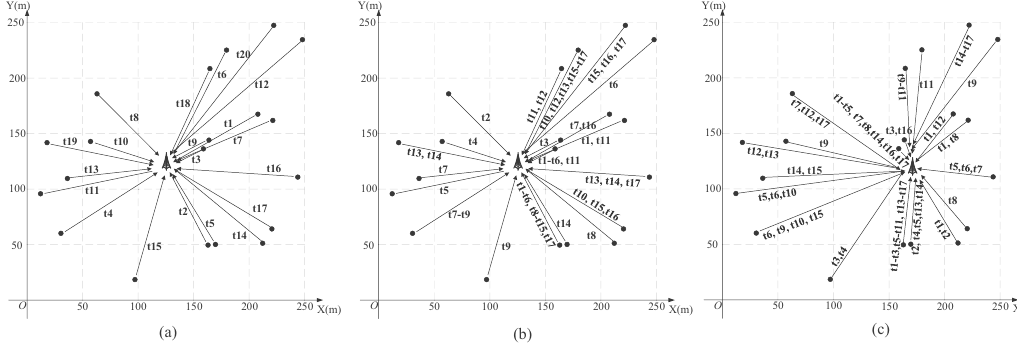
Figure 11. Link scheduling for the 20 -node network with the three schemes. Table 2. The length of each time slot for the three